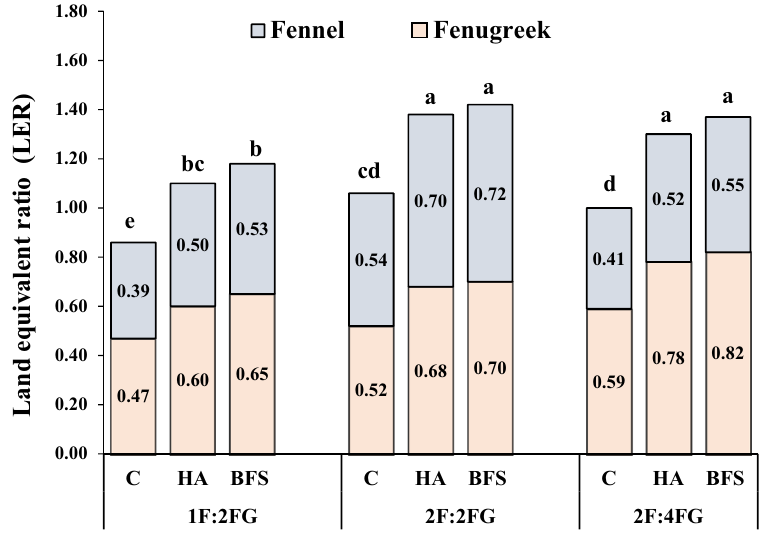
Figure 7. Partial and total land equivalent ratio (LER) for seed yields of different fennel and fenugreek intercropping patterns [1F:2FG, 2F:2FG, 2F:4FG (ratios of fennel and fenugreek in the intercropping patterns)] and fertilization [C (Control), HA (humic acid), BFS (biofertilizers)]. Different lower-case letters above the bars indicate significant (p ≤ 0.05)